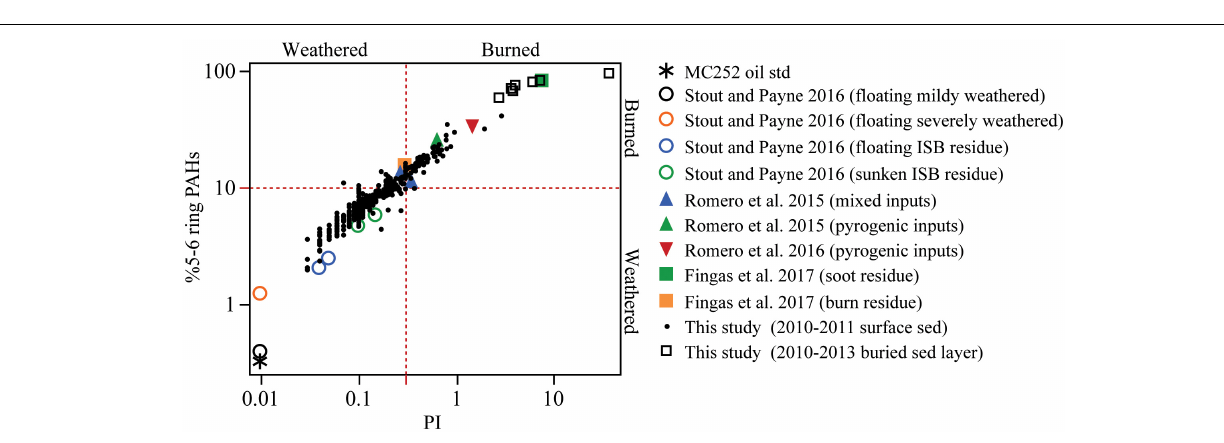
Figure 7 (Shigenaka et al., 2015: ∼ 50% efficiency and PI = ∼ 0.1; Stout and Payne, 2016b: ∼ 89 efficiency and PI = 0.2;